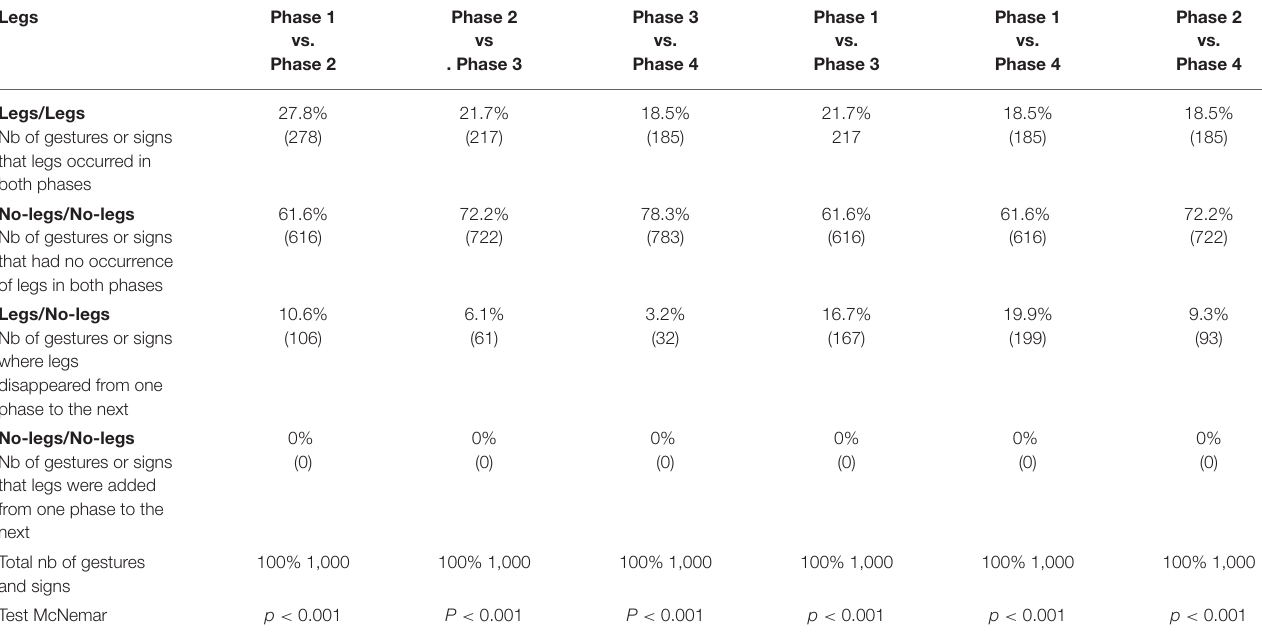
TABLE 4 | McNemar Test: Comparison of pair of phases based on the number of gestures or signs in which legs occurred and not occurred considering the analyzed 1,000 gestures and signs. Legs Phase 1